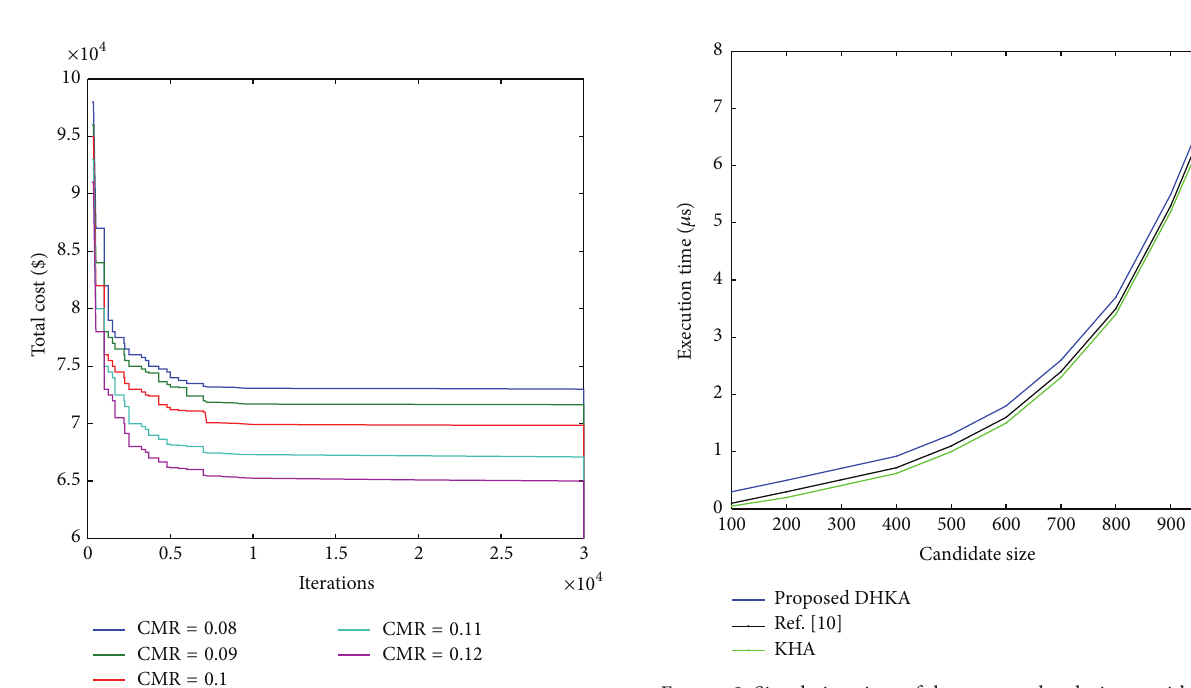
Figure 9: Simulation time of the proposed techniques with respect to candidate size